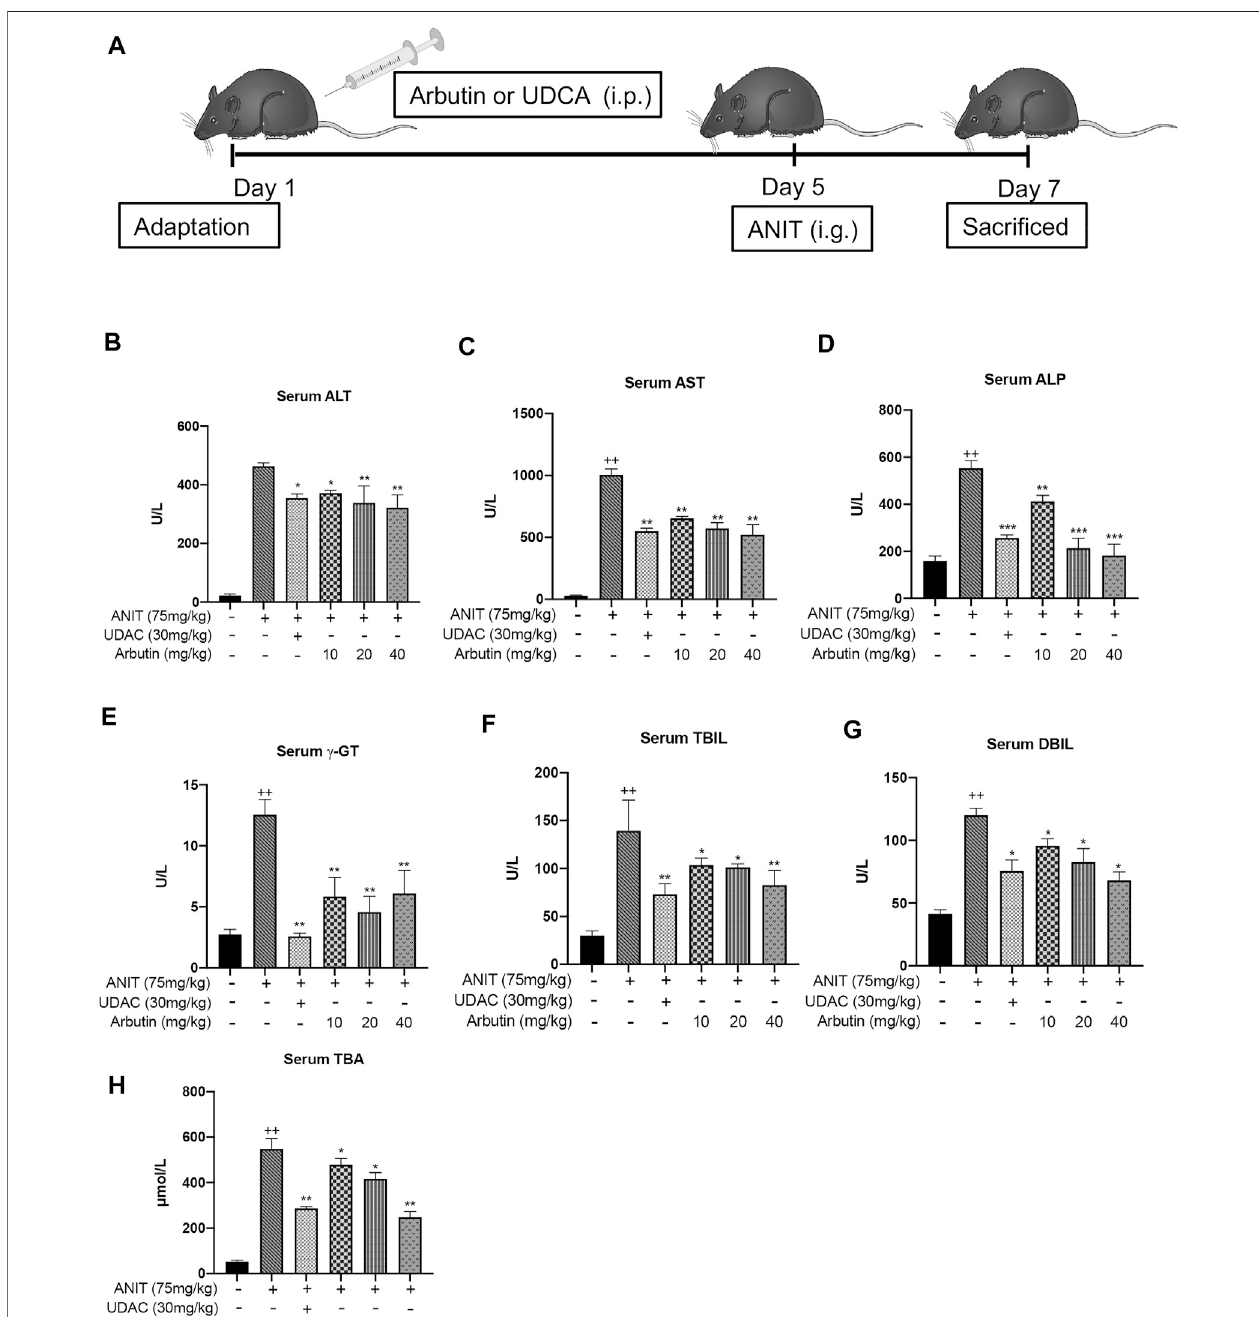
FIGURE2| HepatoprotectiveeffectsofarbutinrelatedtocholestaticliverdamageinducedbyANIT. (A) Theschemefortheanimalexperimentaldesign.Theserum biochemical indicators levels were elevated (B – H) . Data are represented by mean ± SD. ( n (cid:2) 3). p < 0.05; + p < 0.05 vs. control; * p < 0.05 vs. model.